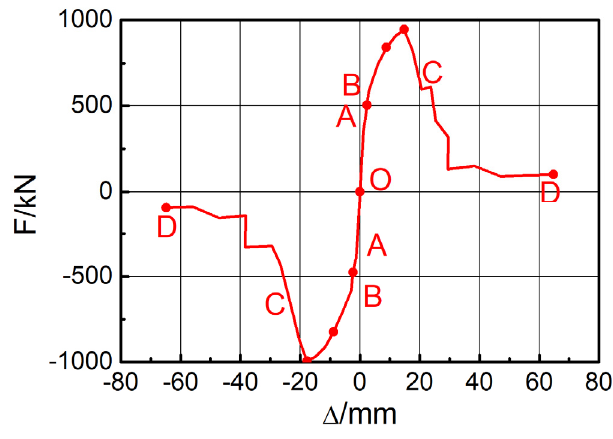
Figure 11. Skeleton curve. A—cracking point; B—yield point; C—peak point; D—point of destruction; O—zero